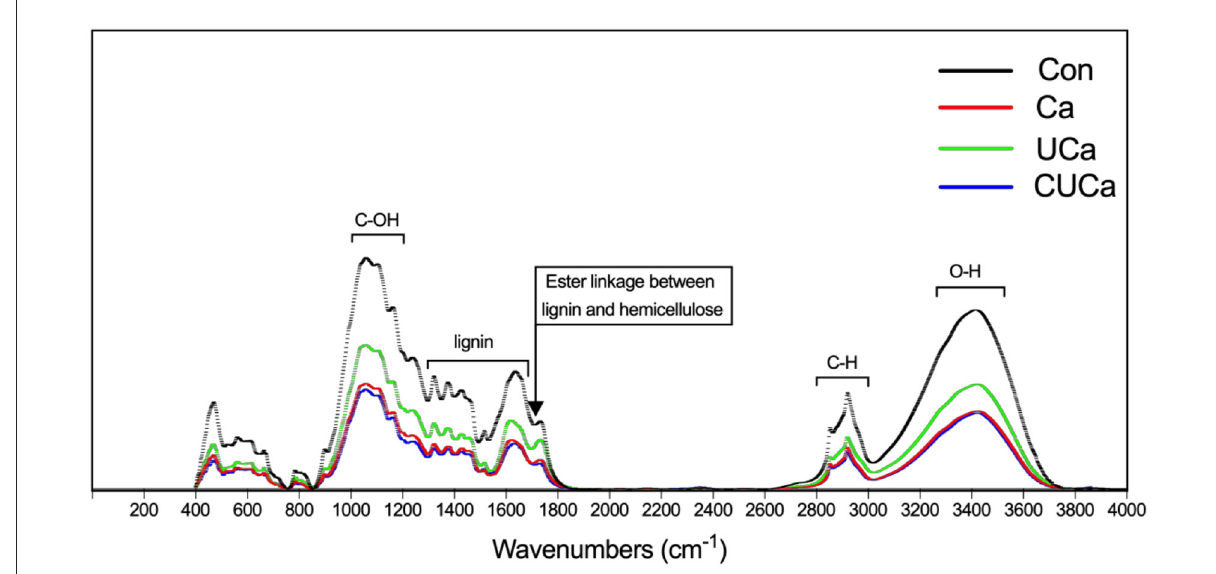
FIGURE1 FTIR spectroscopy of rice straw after CSL plus urea-alkali pretreated. Con: no pretreatment for control group, Ca: 4% CaO, UCa: 2.5% urea + 4% CaO, CUCa: 9% CSL + 2.5% urea + 4% CaO.